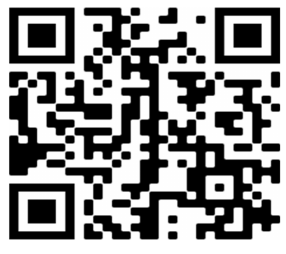
The icons used for representing patients are dots: red dots and blue dots stand for patients with and without the disease, while the “plus” sign denotes a positive test, and the “minus” sign denotes a negative test. The icon array in Figure 6A represent cases as they are treated by a doctor, without any particular ordering, while the icon array in Figure 6B has been sorted so that positive tests are easy to be